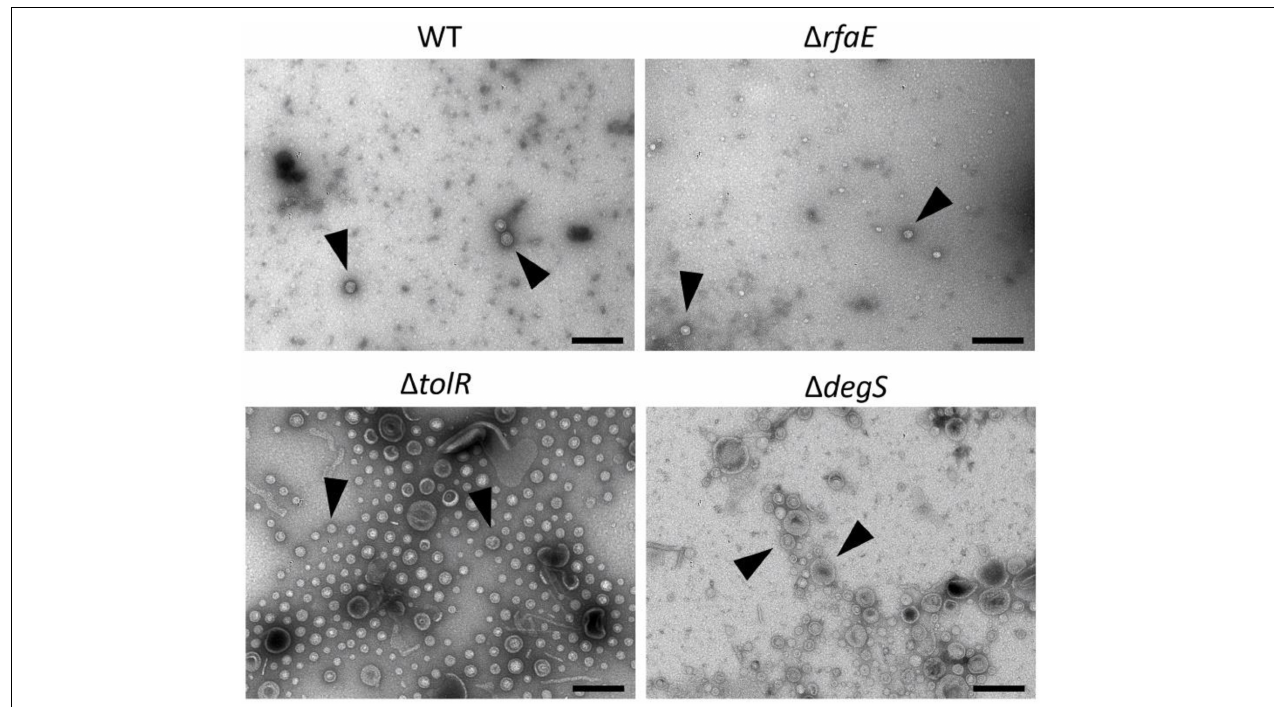
FIGURE 1 | OMVs produced by S. Typhi WT, (cid:49) rfaE , (cid:49) tolR , and (cid:49) degS mutants. Bacteria were grown in LB to OD 600 = 1.0 before extracting OMVs. OMV extracts were observed by transmission electron microscopy (TEM). Arrowheads show OMVs. The black bar corresponds to 200 nm. In all cases, the horizontal field width and the magnification corresponded to 1.5 µ m and 60,000 × , respectively. In each case, a representative experiment is shown ( n = at least 3).